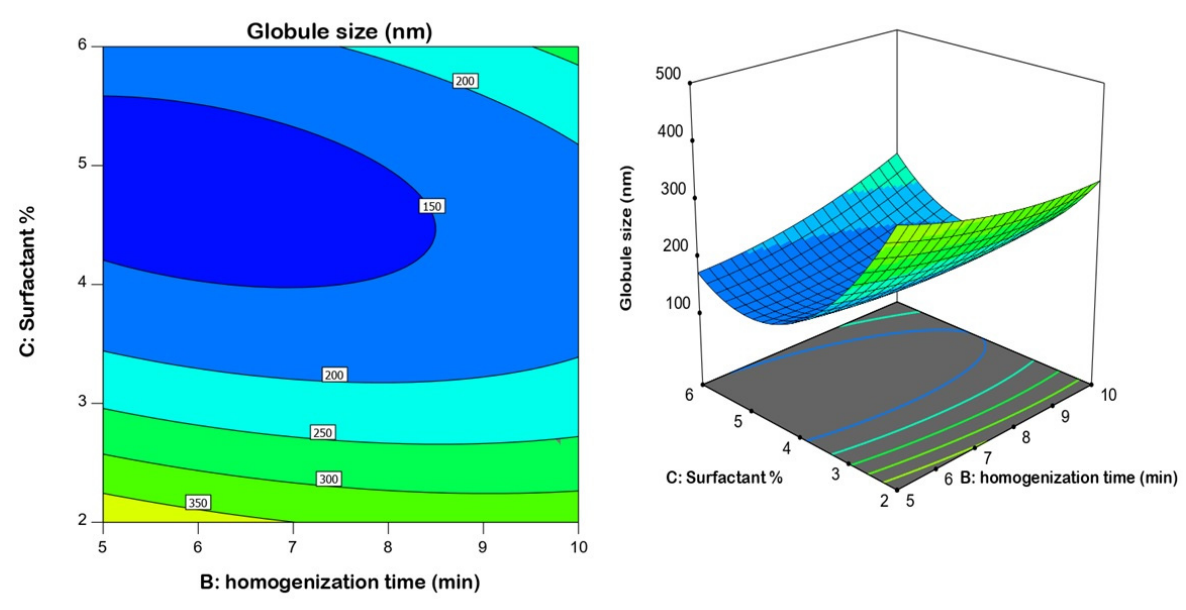
Figure 2. 2D contour and 3D response surface plots revealing the effects of surfactant % and homogenization time at an average speed on nanoemulsion droplet size.